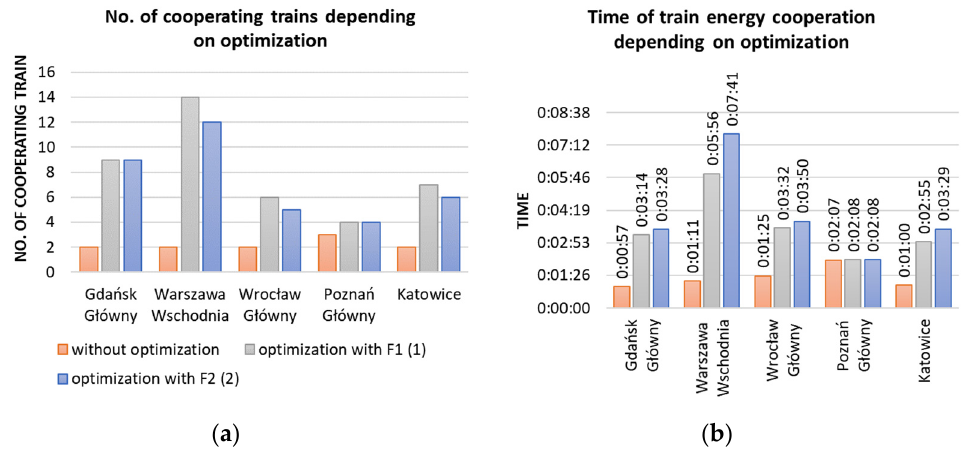
Figure 4. Summary of the results of single-criterion optimization using (a) F 1 (1) and (b) F 2 (2). Source: own study.